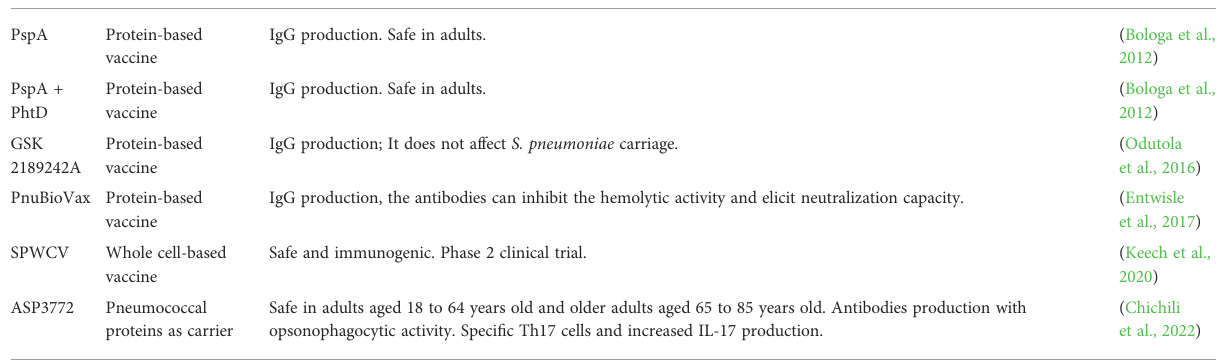
TABLE 3 Non-capsular candidate vaccines in clinical